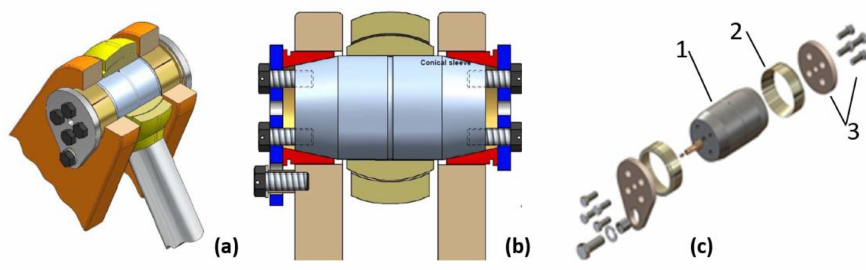
Figure 2. Expanding pin with single set of sleeves: ( a ) pin in joint, ( b ) cross-section view, and ( c ) exploded view.